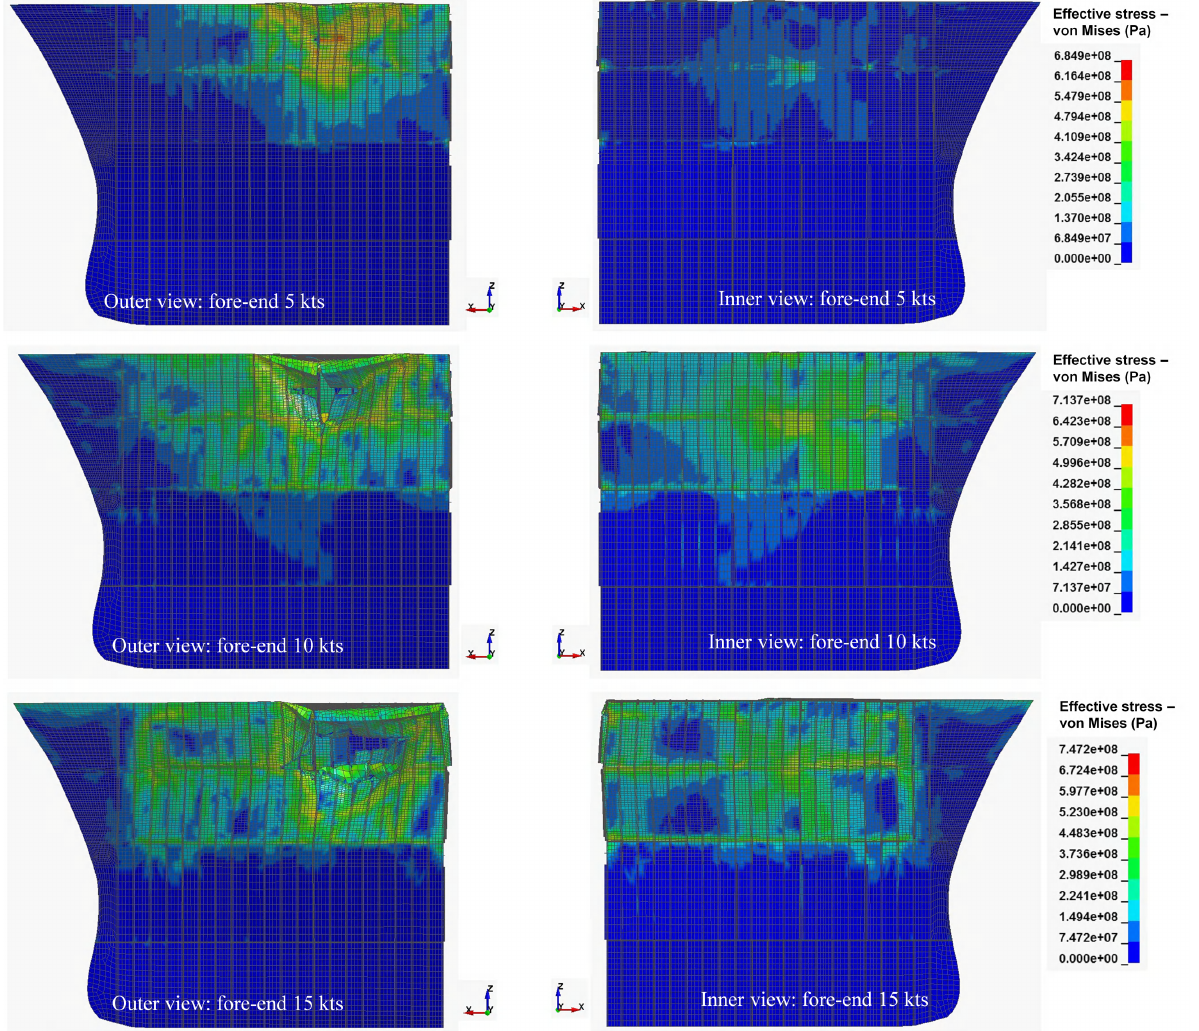
Figure 16: Damage extent and stress contours on the fore-end impacted by the selected striking